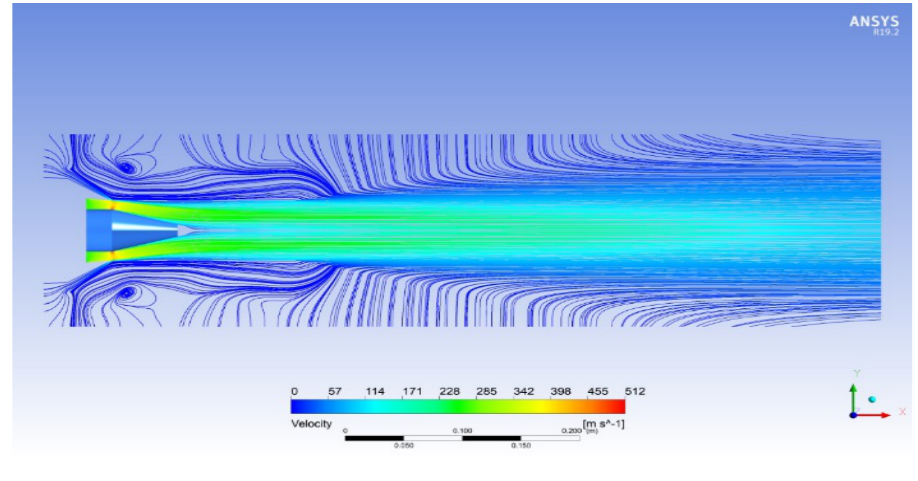
Figure 7. Velocity field and streamlines for the case when section 5 has a value of 1 mm.